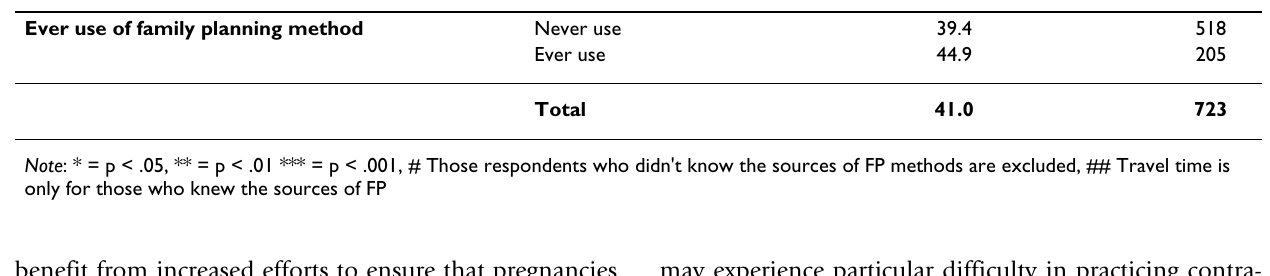
Table 2: Pregnancy intention by selected characteristics